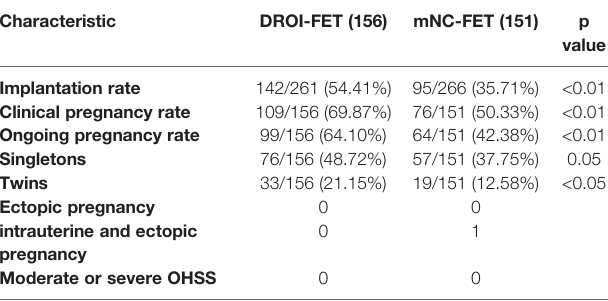
TABLE 3 | Reproductive Outcomes.